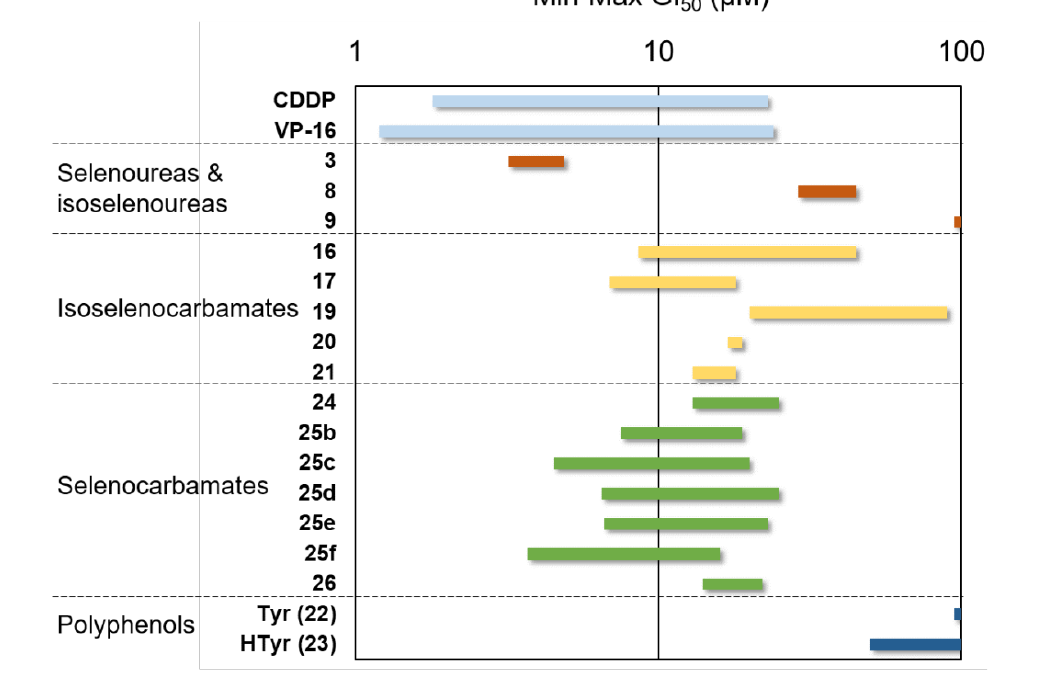
Compounds could be categorized into four different groups according to their antiproliferative activity: strong (GI 50 < 10 µM), good (GI 50 10‒20 µM), moderate (GI 50 20‒100 µM), and inactive ( GI 50 > 100 µM). Overall, most compounds prepared herein were active, exhibiting growth inhibition in all tumour cell lines, unlike isoselenourea 9 and precursors Tyr ( 22 ) and HTyr ( 23 ), which turned out to be in- active, or almost inactive. Interesting structure – activity relationships can be established upon data anal- ysis: N -acylselenourea 3 turned out to be the strongest antiproliferative agent based on the GI 50 range (lower than 5.0 µM in all cell lines); this compound exhibited a comparable potency to CDDP in A549, HBL-100 and Hela cell lines, and improved activity (roughly 5.0-fold) for the multidrug-resistant lines. Conversion of 3 into Se-phenacyl isoselenoureas clearly provoked an impair- ment of the activity; thus a 10-fold decrease in activity was found for 8 , and com- plete abolishment of activity for 9 (Table 3). These results show a pivotal influence of the nature of the organoselenium motif on antiproliferative activity, and they suggest that the selone functionality (C=Se) could be crucial. Isoselenocarbamates 16 ‒ 21 were also accessed, where the influence of both the nature of the N -aryl system and the number of phenolic hydroxyl groups could be analysed. Incorporation of one hydroxyl group ( 17 vs. 16 ; 20 vs. 19 ) had a clear positive effect on activity; however, the presence of one or two hydroxyl groups (catechol moiety) did not seem to have much influence, as the activity of derivatives 20 (GI 50 15 – 21 µM) and 21 (GI 50 13 – 18 µM) was found to be virtually the same. Additionally, the use of an N -phenyl substituent compared to N-naphthyl also improved activity, particularly against A549, HBL-100 and T-47D lines.